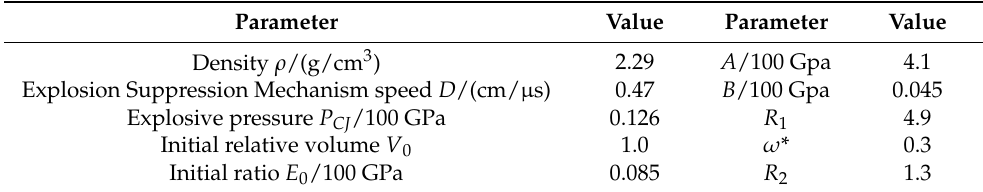
Table 2. Values for the material parameters of the copper azide primer and the material pressure state equation constants in the explosion suppression mechanism field.